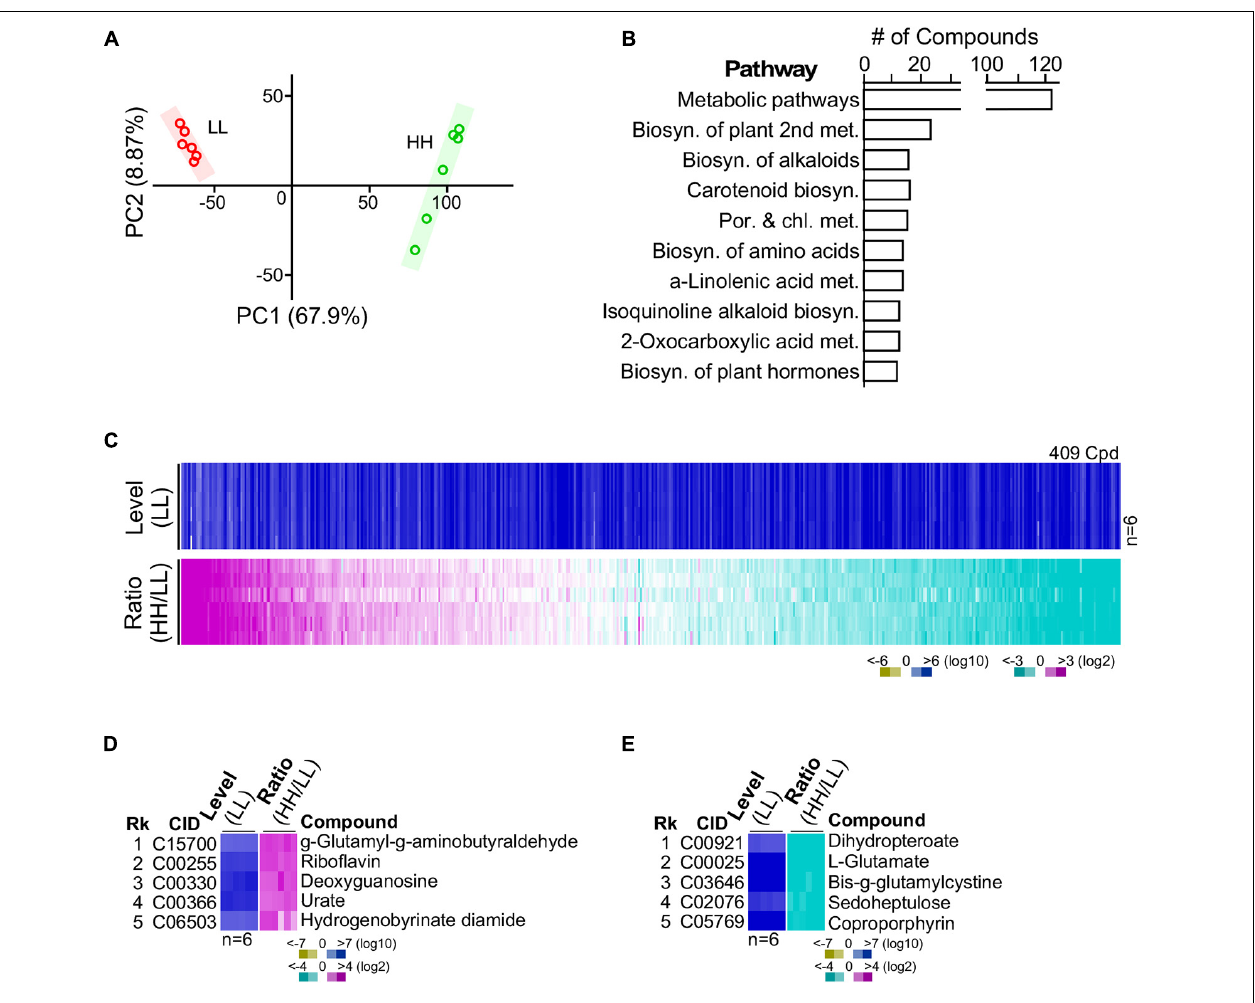
FIGURE 4 | Metabolite profiling of G32 cells maintained in media supplemented with high-level and low-level glucose. (A) High correlation between profiles of repeated experiments using principal component analysis. (B) Top 10 numbers of pathway-associated metabolites. (C) Profile of metabolites in cells cultivated with high and low glucose supplements. (D) Top five upregulated metabolites. (E) Top five downregulated